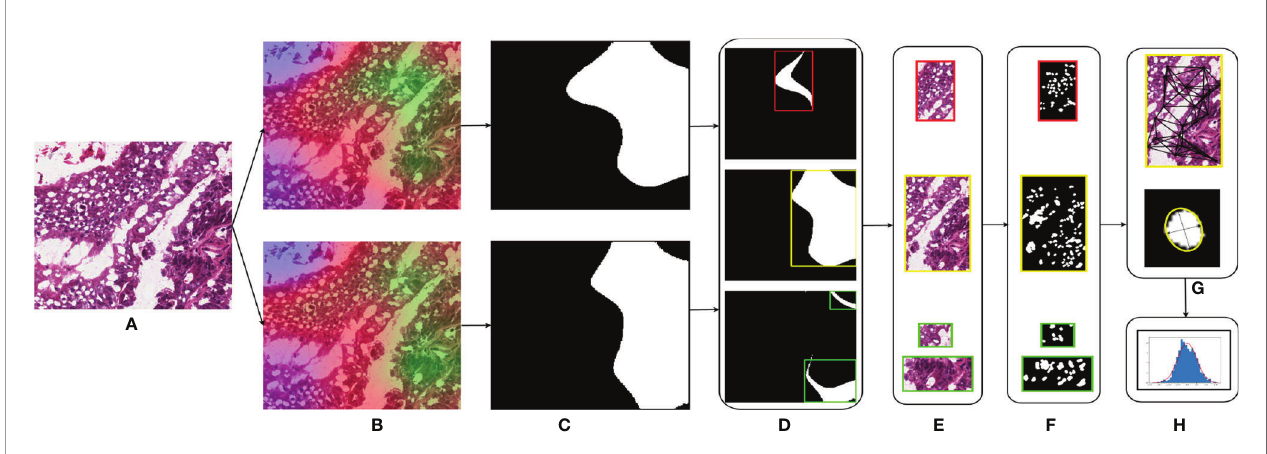
FIGURE 3 | Nucleus segmentation work fl ow involved in segmenting nuclei from the speci fi c regions of a sample patch: (A) COAD sample patch, (B) GradCAM outputs of BRCA model (top) and COAD model (bottom), (C) thresholded GradCAM mask, (D) BRCA-speci fi c mask (top), overlapping mask (middle), and COAD- speci fi c mask (bottom), (E) masked regions of BRCA-speci fi c (top), overlap (middle), and COAD-speci fi c (bottom), (F) nucleus segmented regions of BRCA-speci fi c (top), overlap (middle), and COAD-speci fi c (bottom), (G) obtaining the nucleus shape and graphical features for each region, and (H) distributions of these